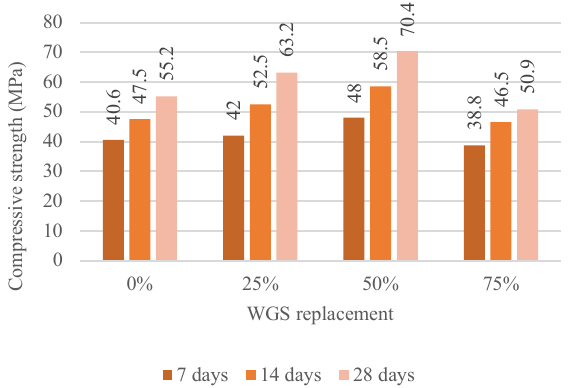
Figure 7. Compressive Strength Results at 7, 14, and 28 days for cubic specimens.